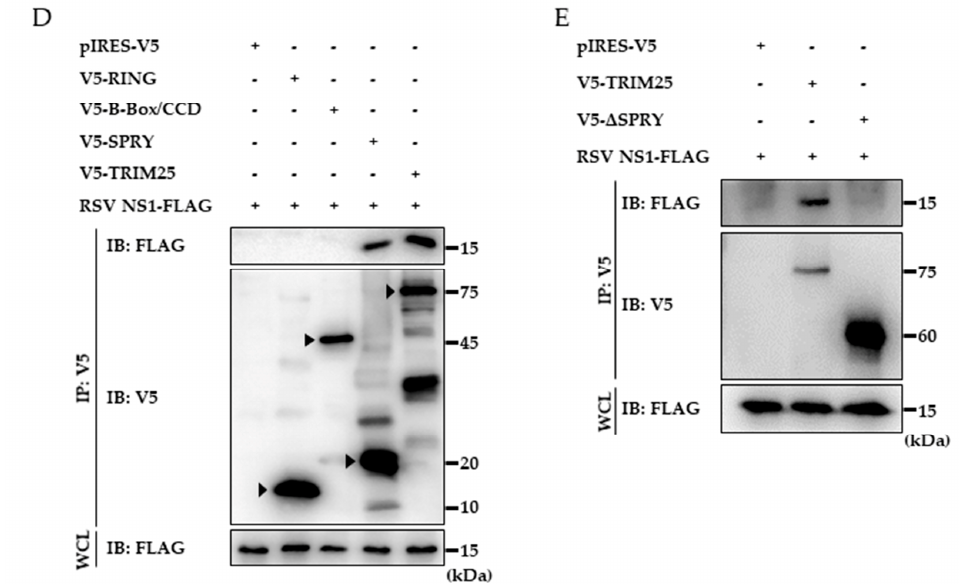
Figure 3. Interaction between RSV NS1 and TRIM25. ( A ) To test whether RSV NS proteins interact with TRIM25, V5-TRIM25 was expressed with RSV NS1-FLAG or NS2-HA in HEK293T. Whole cell lysates (WCL) were subjected to co-immunoprecipitation (co-IP) and immunoblotting using indicated antibodies. ( B ) FLAG-tagged RSV NS1 was overexpressed in HEK293T. Cell lysates were immunoprecipitated with anti-FLAG antibody and analyzed by immunoblotting. ( C ) HEK293T cells were transfected with FLAG-tagged NS1 and V5-tagged TRIM25 expression plasmids. Localization of NS1 and TRIM25 were visualized by primary antibodies and FITC- and PE-labeled secondary antibodies as described in Material and Methods. The lower panel shows the intensity of NS1 (green) and TRIM25 (red) along the white line of the upper panel images. ( D ) TRIM25 truncated mutants including V5-tagged RING, B-box/CCD and SPRY domain constructs were expressed in HEK293T cells together with RSV NS1. Co-IP was performed followed by immunoblotting. The arrowheads indicate the bands with correct size of each construct. ( E ) Wild type TRIM25 or SPRY deletion ( ∆ SPRY) mutant plasmid was transfected with RSV NS1-FLAG followed into HEK293T cells. Interaction was analyzed by co-IP and immunoblotting as indicated. All experiments were conducted at least three times with similar